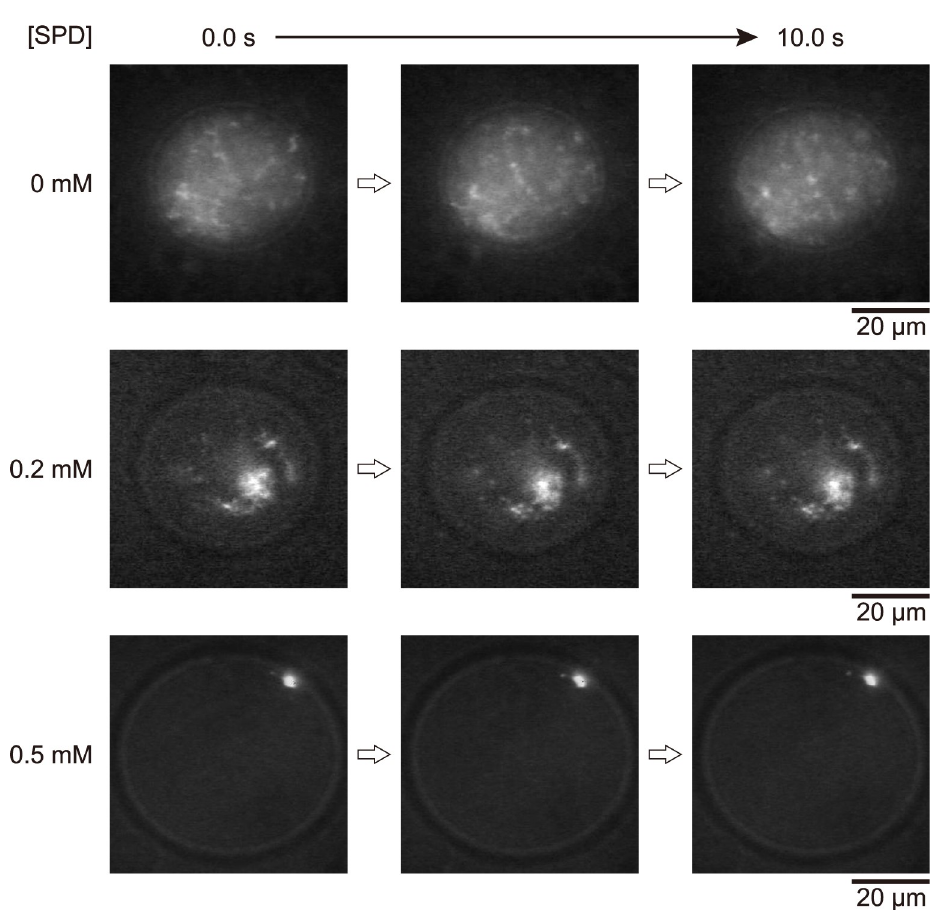
Fig 2. FM observation of w/w microdroplets entrapping several T4 GT7 DNA molecules. The microdroplets were generated through phase separation of PEG/DEX solution under the conditions similar to those in Fig 1, except for the DNA concentration of 40 μ M in nucleotide units. The total observation time is 10